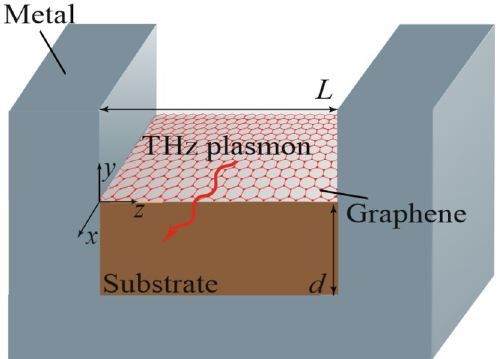
Figure 1. Schematic view of the structure under consideration.